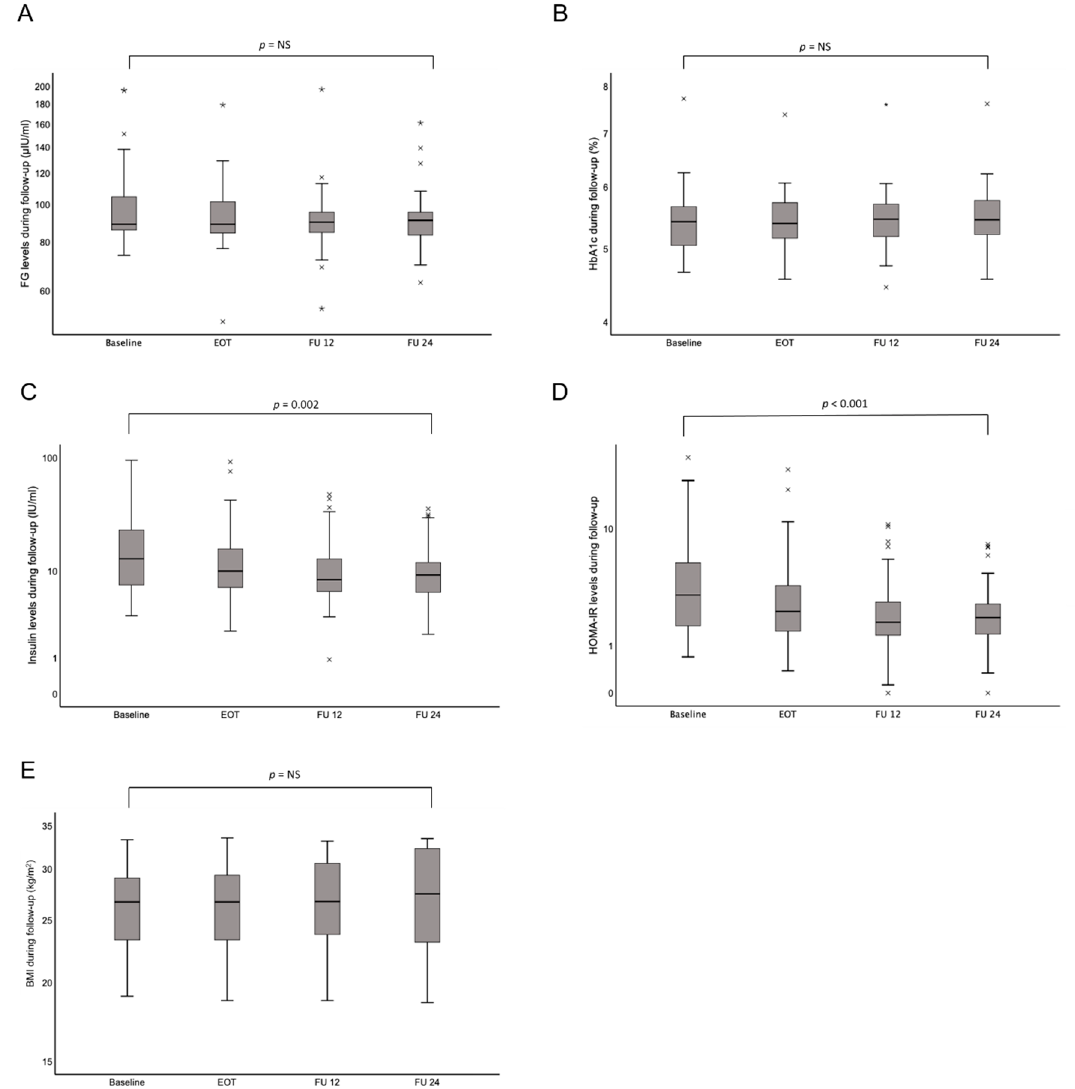
Figure 1. Changes in metabolic parameters over time, during and after DAA therapy. ( A ) Fasting glucose (FG), ( B ) HbA1c, ( C ) insulin, ( D ) HOMA-IR, and ( E ) BMI. The top and bottom of the boxes are the first and third quartiles, respectively. The middle line through the middle of each box represents the median. × represents mild outliers which lie between 1.5 and 3.0 times the IQR. * represents extreme outliers which lie more than 3.0 times the IQR. Abbreviations: BMI, body mass index; FG, fasting glucose; HOMA-IR, homeostasis model of insulin resistance.